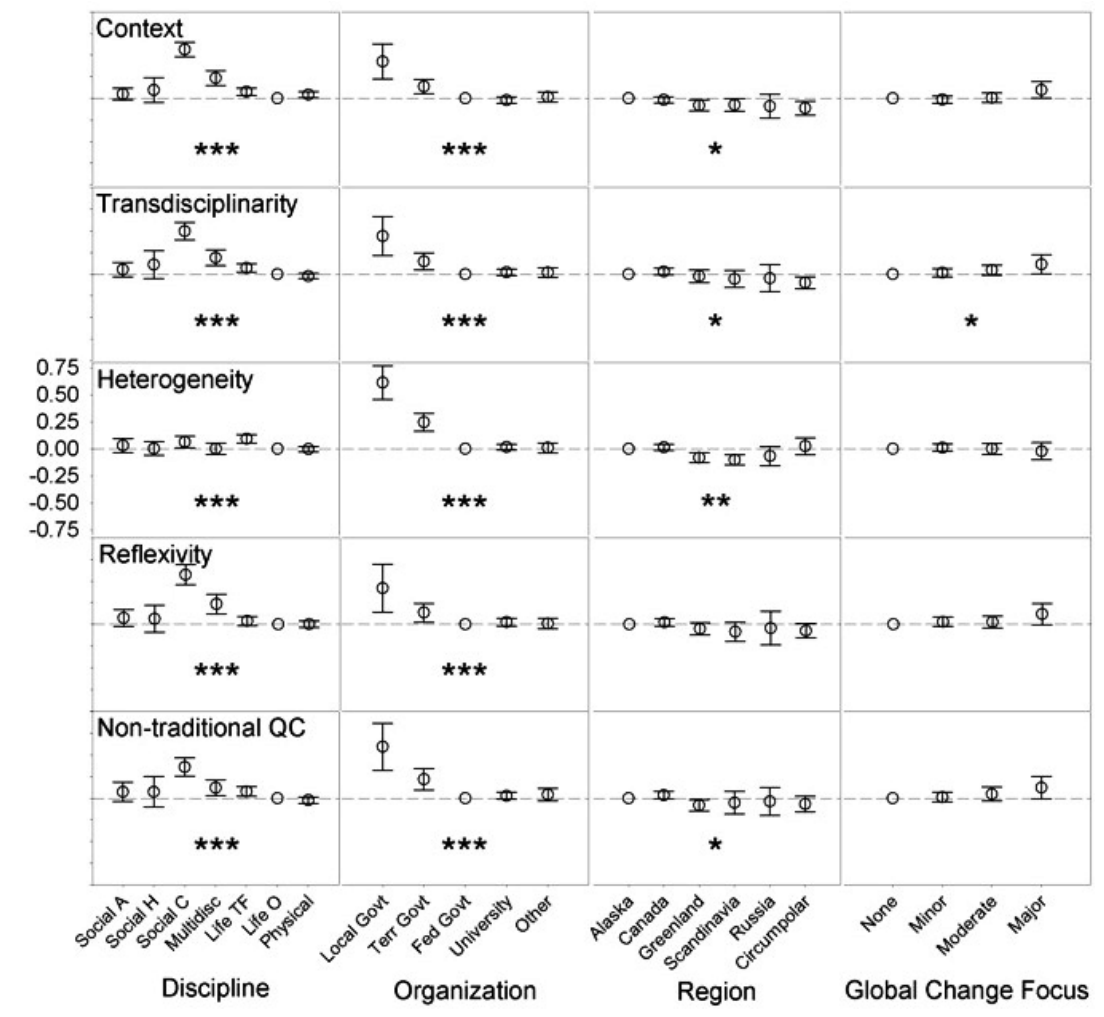
Fig. 2 . Regression coefficients from an initial multiple regression analysis of Mode score predicted by the five explanatory variables included. Coefficients are expressed relative to one arbitrarily chosen level of each explanatory variable, which has a value constrained to 0. Therefore, it is arbitrary whether most points are above, below, or grouped around the line, but the general direction of the trend is meaningful. Points higher on the Y-axis, with error bars that do not overlap with other points, are more Mode 2 than the points of comparison that are lower on the Y-axis and more Mode 1. Therefore, for example, social sciences, local governments, and Alaska are all more Mode 2 than their